Question: Condense the content of this figure into a single sentence.
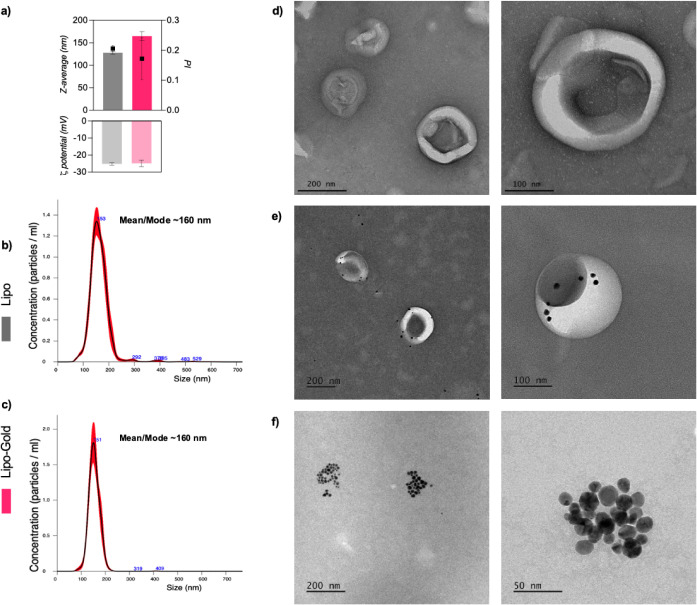
Answer: Physicochemical characterization of Lipo and Lipo-Gold nanoparticles. a) DLS analysis showing the Z-average hydrodynamic diameter, polydispersity index, and ZP, reported as the mean of three independent measurements. b) NTA size distribution of Lipo, obtained from five measurements and analyzed using FTLA (Finite Track Length Adjustment), a fitting method that corrects for particle trajectory truncation and provides a more accurate estimation of the modal particle size. c) NTA size distribution of Lipo-Gold nanoparticles based on five measurements and processed with FTLA fitting. d) Representative TEM images of UAR-stained Lipo highlighting vesicle morphology. e) TEM images of Lipo-Gold after UAR staining, showing both the lipid structure and the associated gold nanoparticles. f) TEM images of Lipo-Gold without UAR staining, where contrast arises primarily from the gold cores.